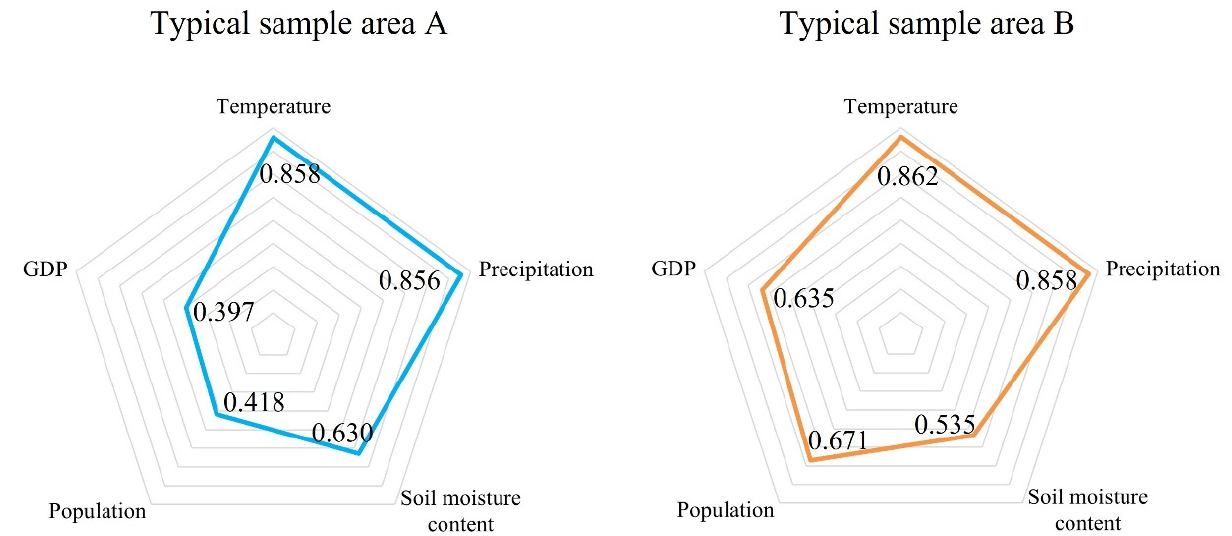
Figure 10. Impact level of factors in typical sample areas.